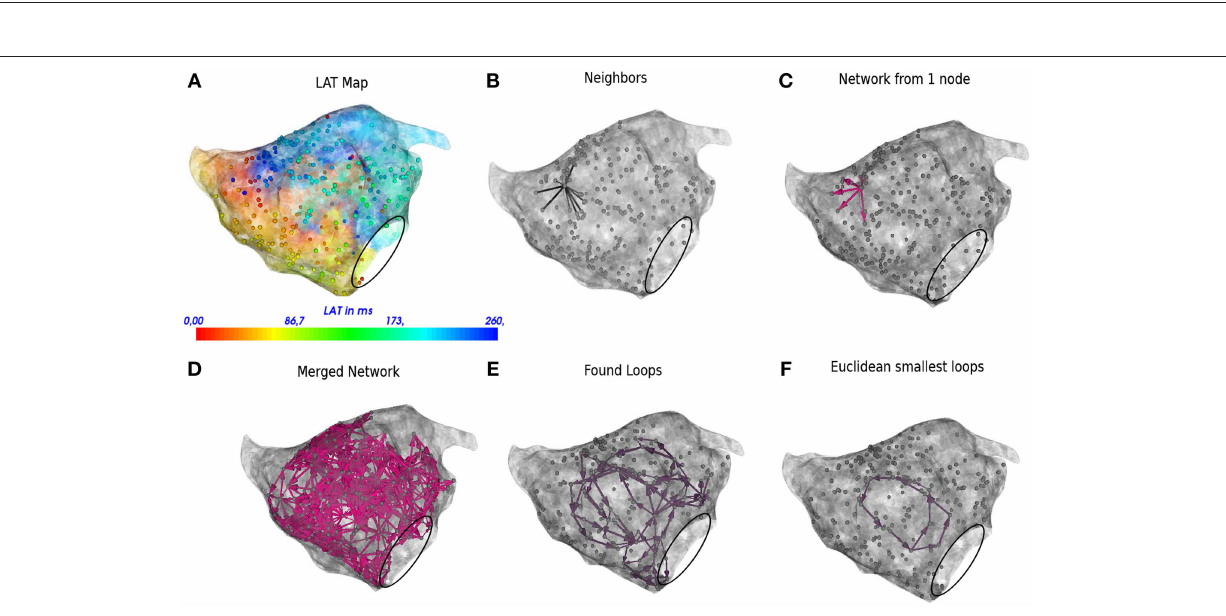
Frontiers in Physiology | www.frontiersin.org